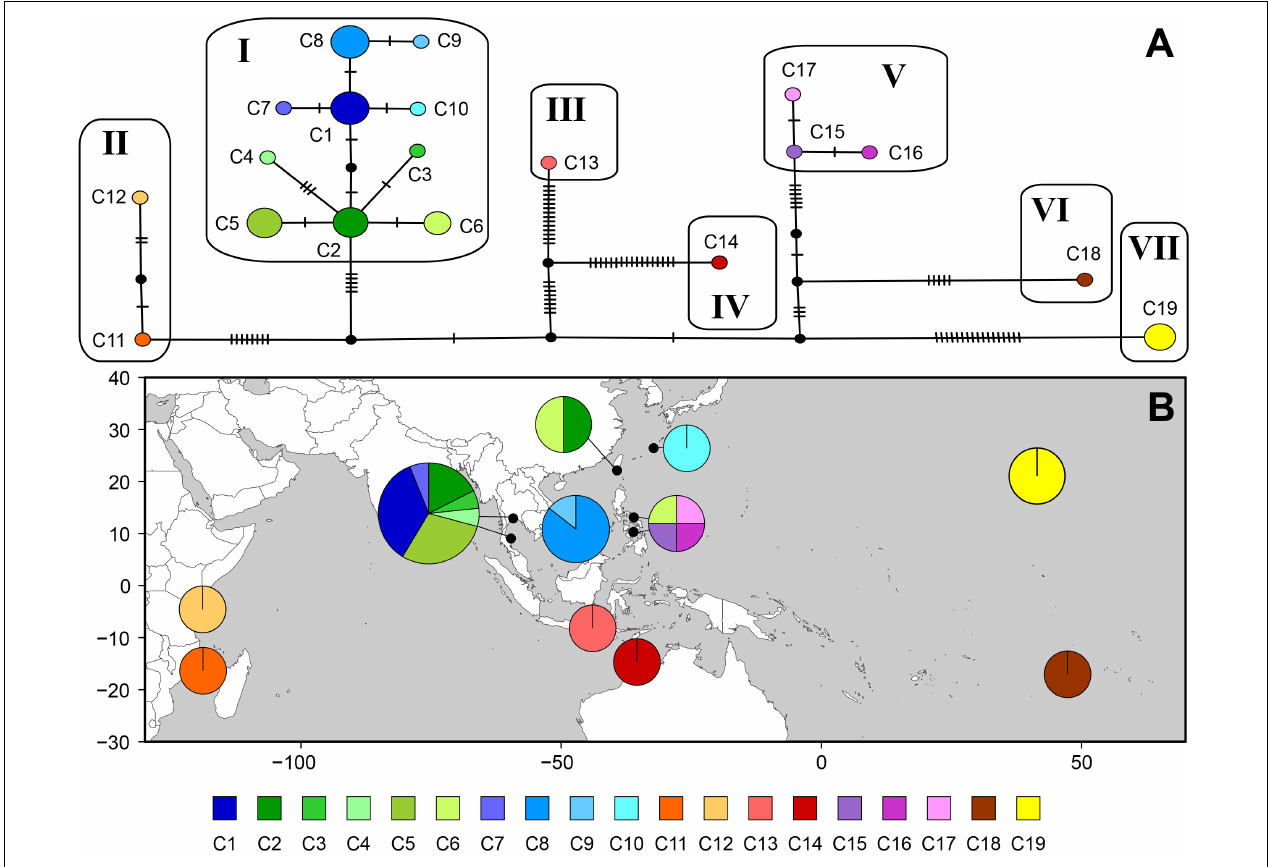
FIGURE 4 | Haplotype network (A) and geographic distribution of haplotypes (B) based on mitochondrial cox 1 for Gelidiella fanii . (A) Each circle denotes a single haplotype with size proportional to frequency. Each connecting line indicates one mutation step between haplotypes. Filled circle indicates inferred unsampled or extinct haplotypes. (B) Pie chart denotes the proportion of haplotypes present in each population. Haplotype is colored as shown in the key. TABLE 4 | Non-hierarchical and hierarchical analyses of molecular variance (AMOVA) of mitochondrial cox 1 from Gelidiella fanii .